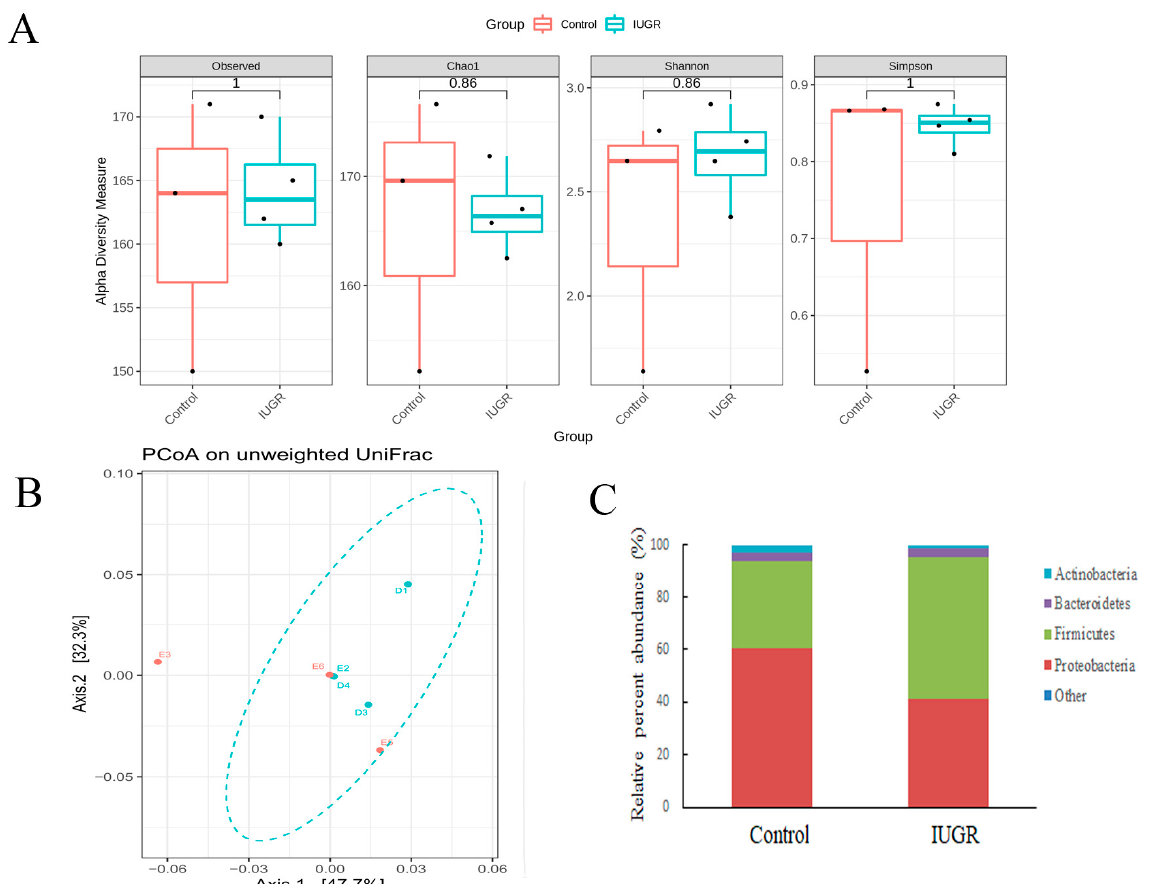
Figure 3. Impact of bilateral uterine artery ligation (IUGR group) or sham surgery (control group) on gestation day 18 on the maternal gut microbiota. Bilateral uterine artery ligation did not alter ( A ) α -diversity indices (observed, Chao1 index, Shannon, or Simpson), ( B ) β -diversity (PCoA on unweighted UniFrac distances), or ( C ) bacterial composition of the maternal gut microbiota at the phylum level. Other means the bacterial with lower abundances include Acidobacteriota, Campilobac- terota, Cyanobacteria, Desulfobacterota, Fusobacteriota, Verrucomicrobiota. Data are shown as box-and-whisker plots. Control group n = 3 and IUGR group n = 4 dams in each